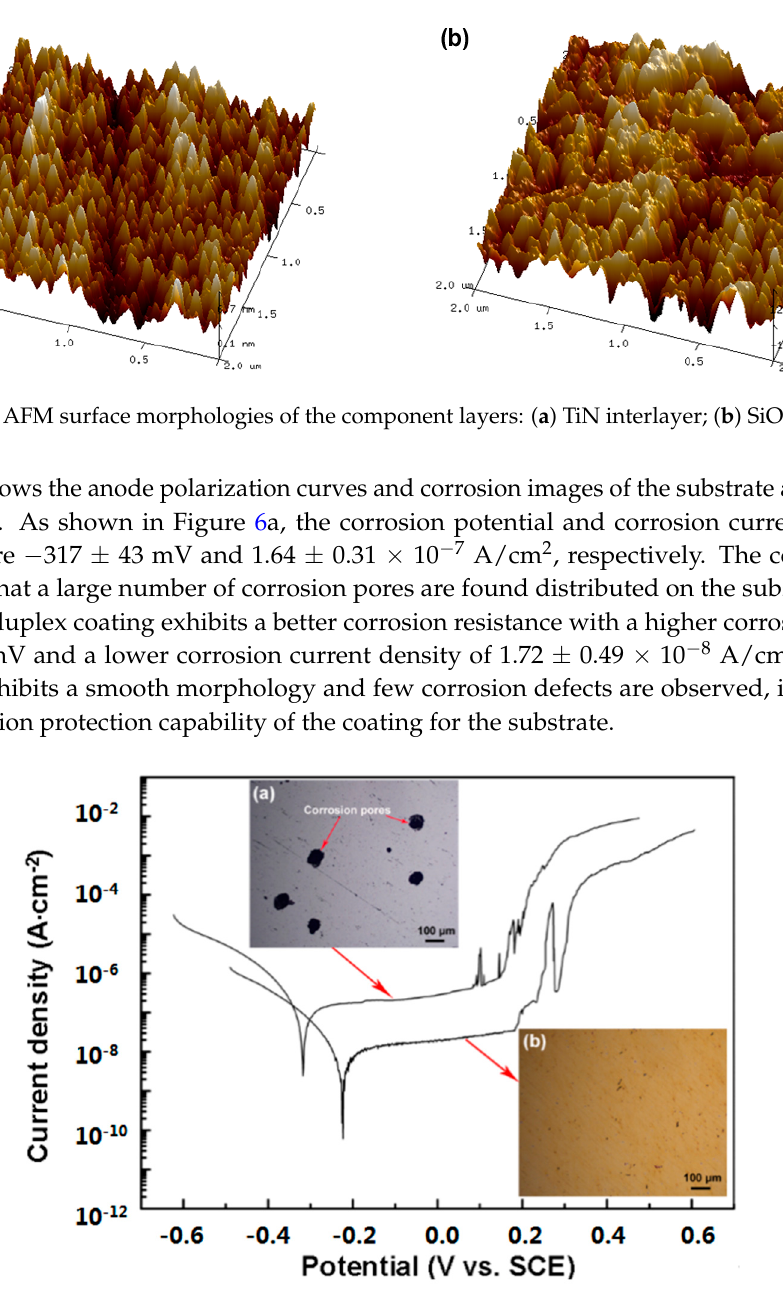
Figure 6. Anode polarization curves and corrosion morphologies of ( a ) substrate and ( b ) TiN/SiO x duplex coating.